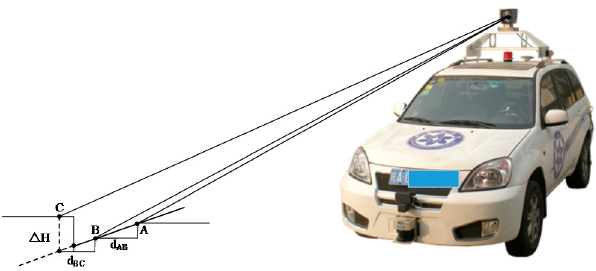
Figure 7. Schematic diagram for height difference based on the prediction of the radial gradient.